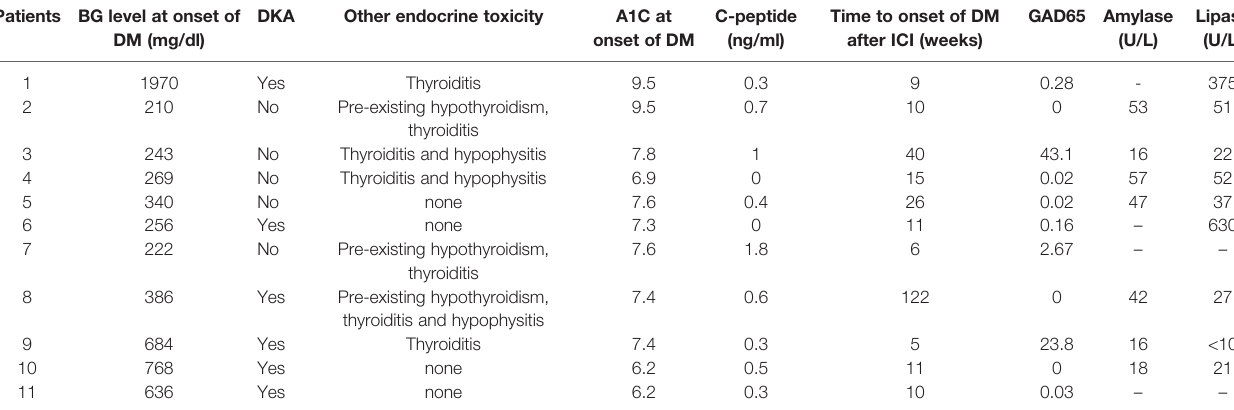
TABLE 2 | Clinical and biochemical features. Patients BG level at onset of DM